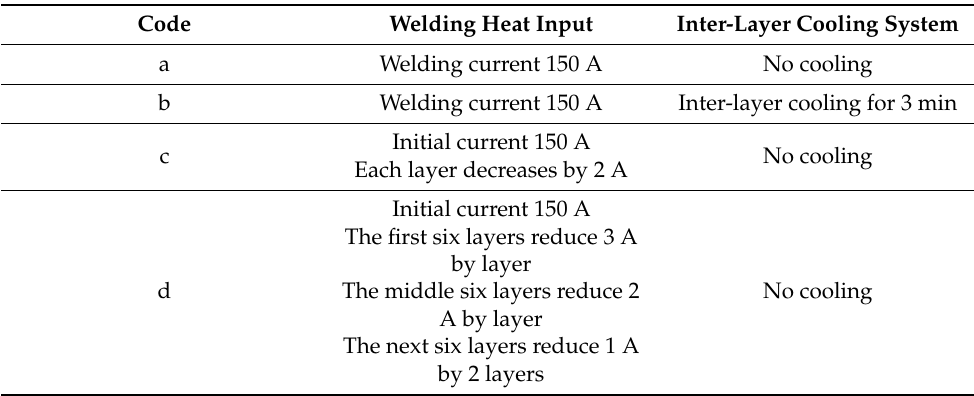
Table 3. Process parameter table for changing heat input and inter-layer